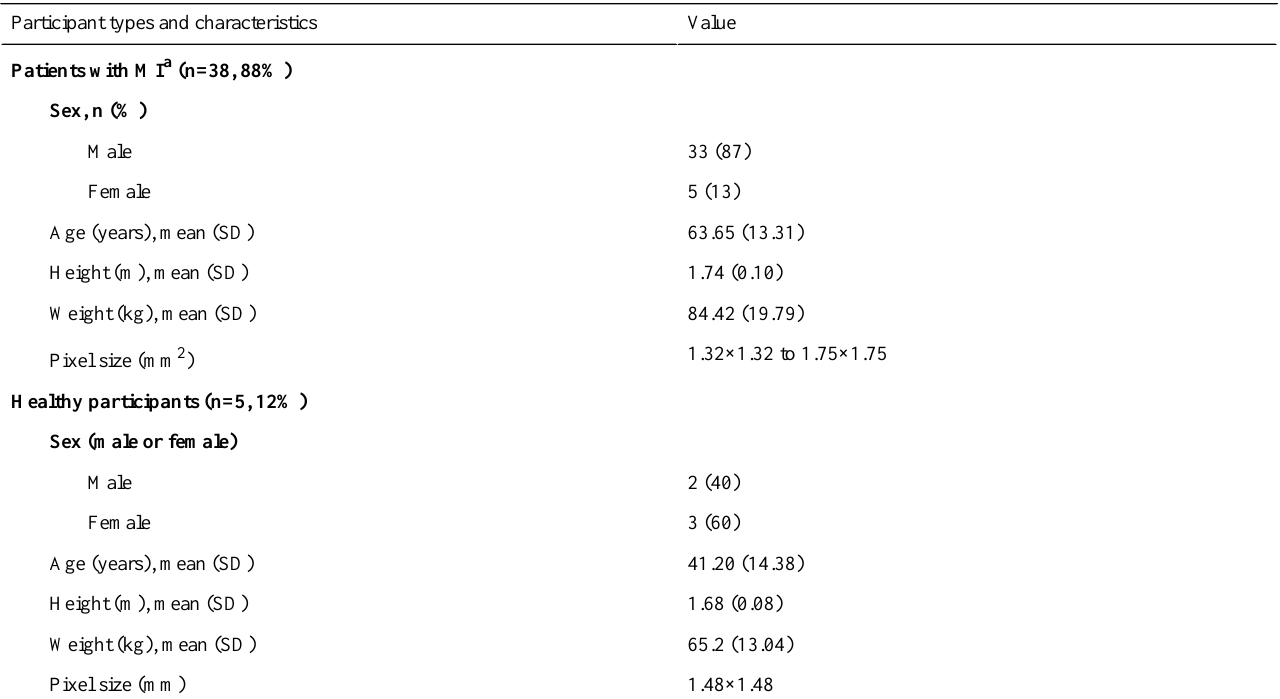
Table 1. Characteristic details of the data set (N=43). ValueParticipant types and